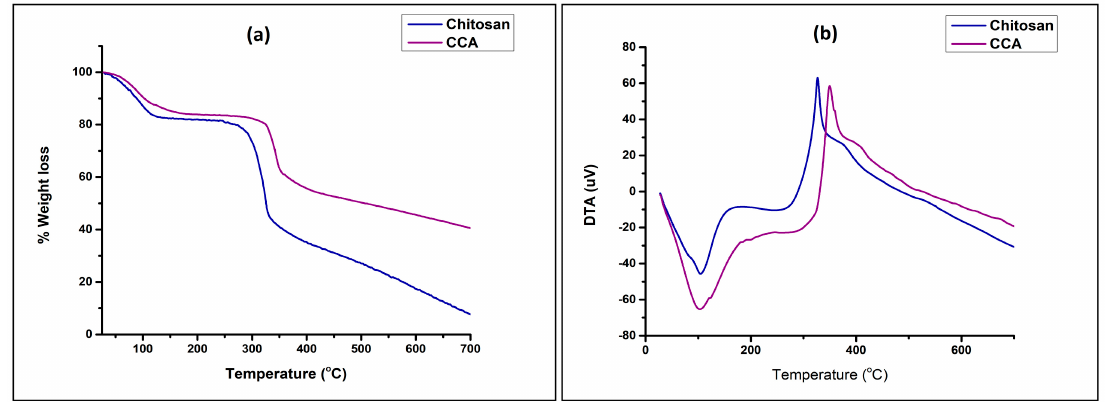
Figure 3. ( a ) TGA curves and ( b ) DTA curves of chitosan and CCA.